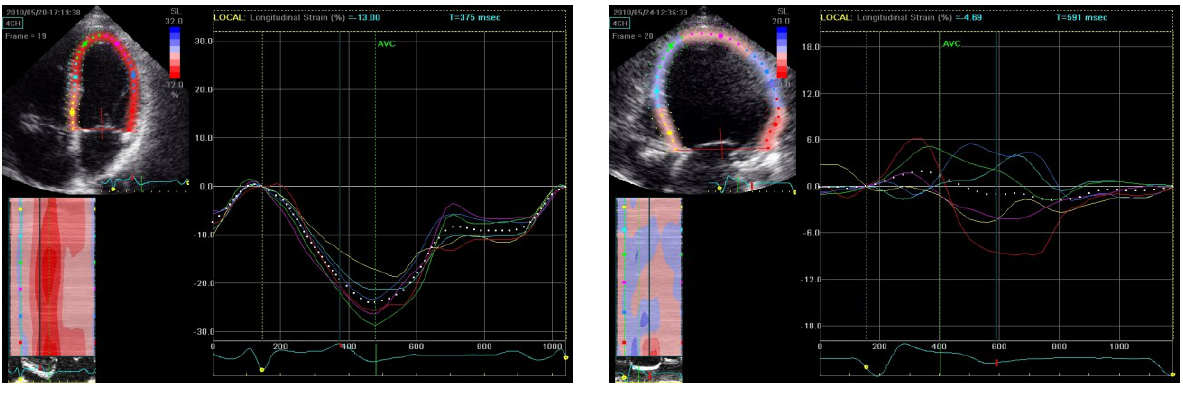
Figure 2. Regional and Global Longitudinal Strain. Examples of instantaneous regional longitudinal strain (color coded segmental lines) and global longitudinal strain (white dotted lines) measured over a cardiac cycle (EchoPAC™, General Electric). The heart (left) demonstrates a normal shape, volume and maximal global longitudinal strain with segmental homogeneity. The heart (right) demonstrates a severe cardiomyopathy with spherical remodeling, increased ventricular cavity volume, reduced maximal global longitudinal strain and segmental